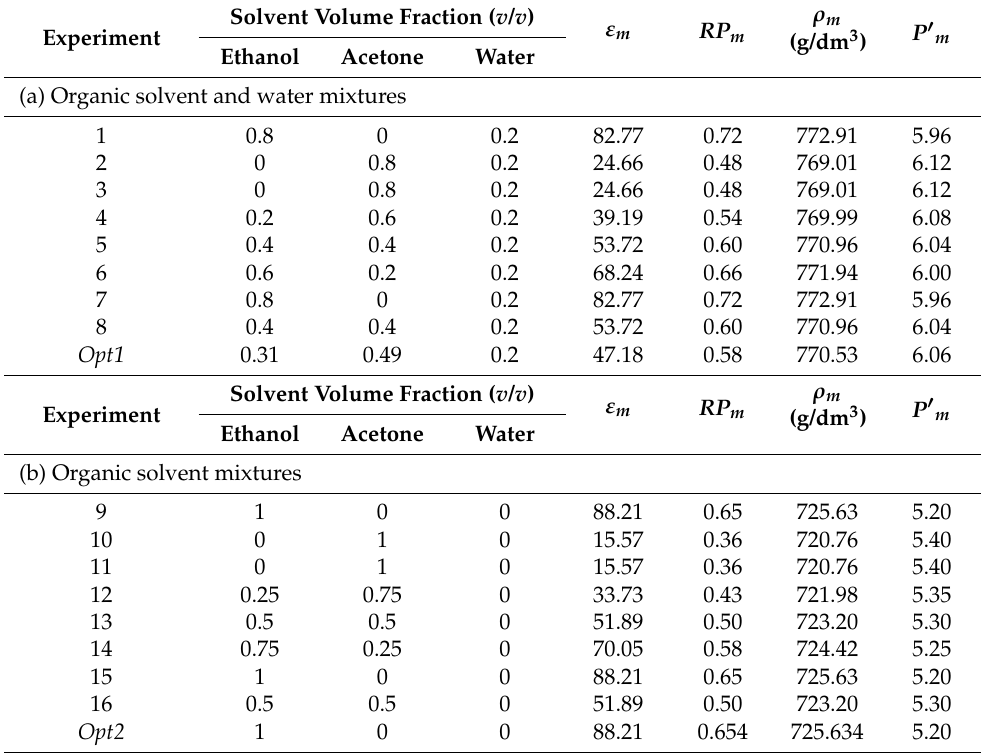
Table 1. The calculated physicochemical properties solvent mixtures used in the SRD analysis of extraction